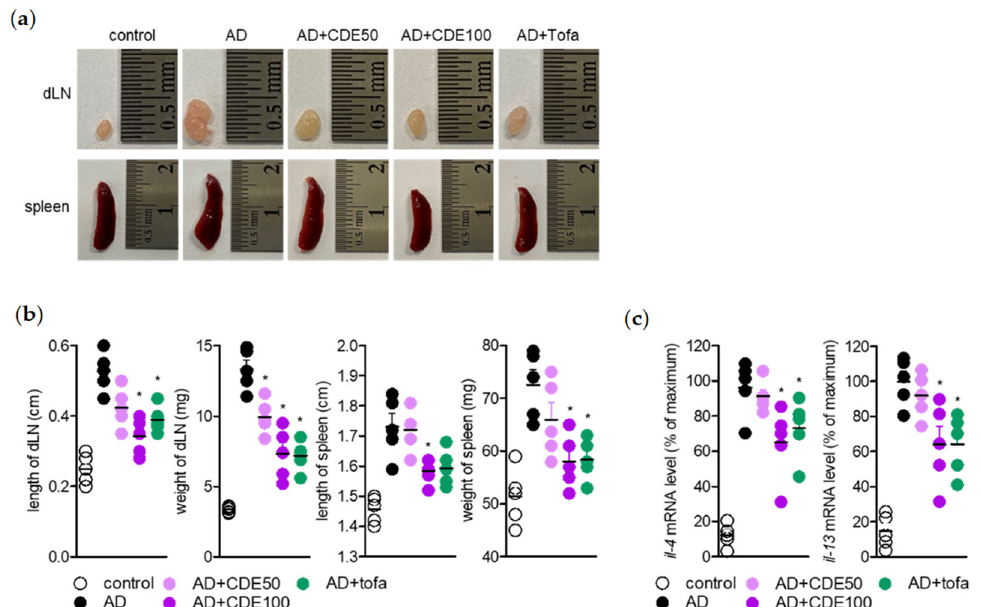
Figure 5. CDE blocks systemic immune responses in atopic dermatitis. ( a ) Representative photo ‐ graphs of draining lymph nodes and spleen in each group. ( b ) Length and weight of draining lymph nodes and spleen for each mouse at day 28 after AD induction. ( c ) mRNA levels of T cell ‐ mediated cytokines in draining lymph nodes were detected by real ‐ time quantitative PCR. Results are pre ‐ sented as mean ± SEM of 5 mice (* p < 0.05).